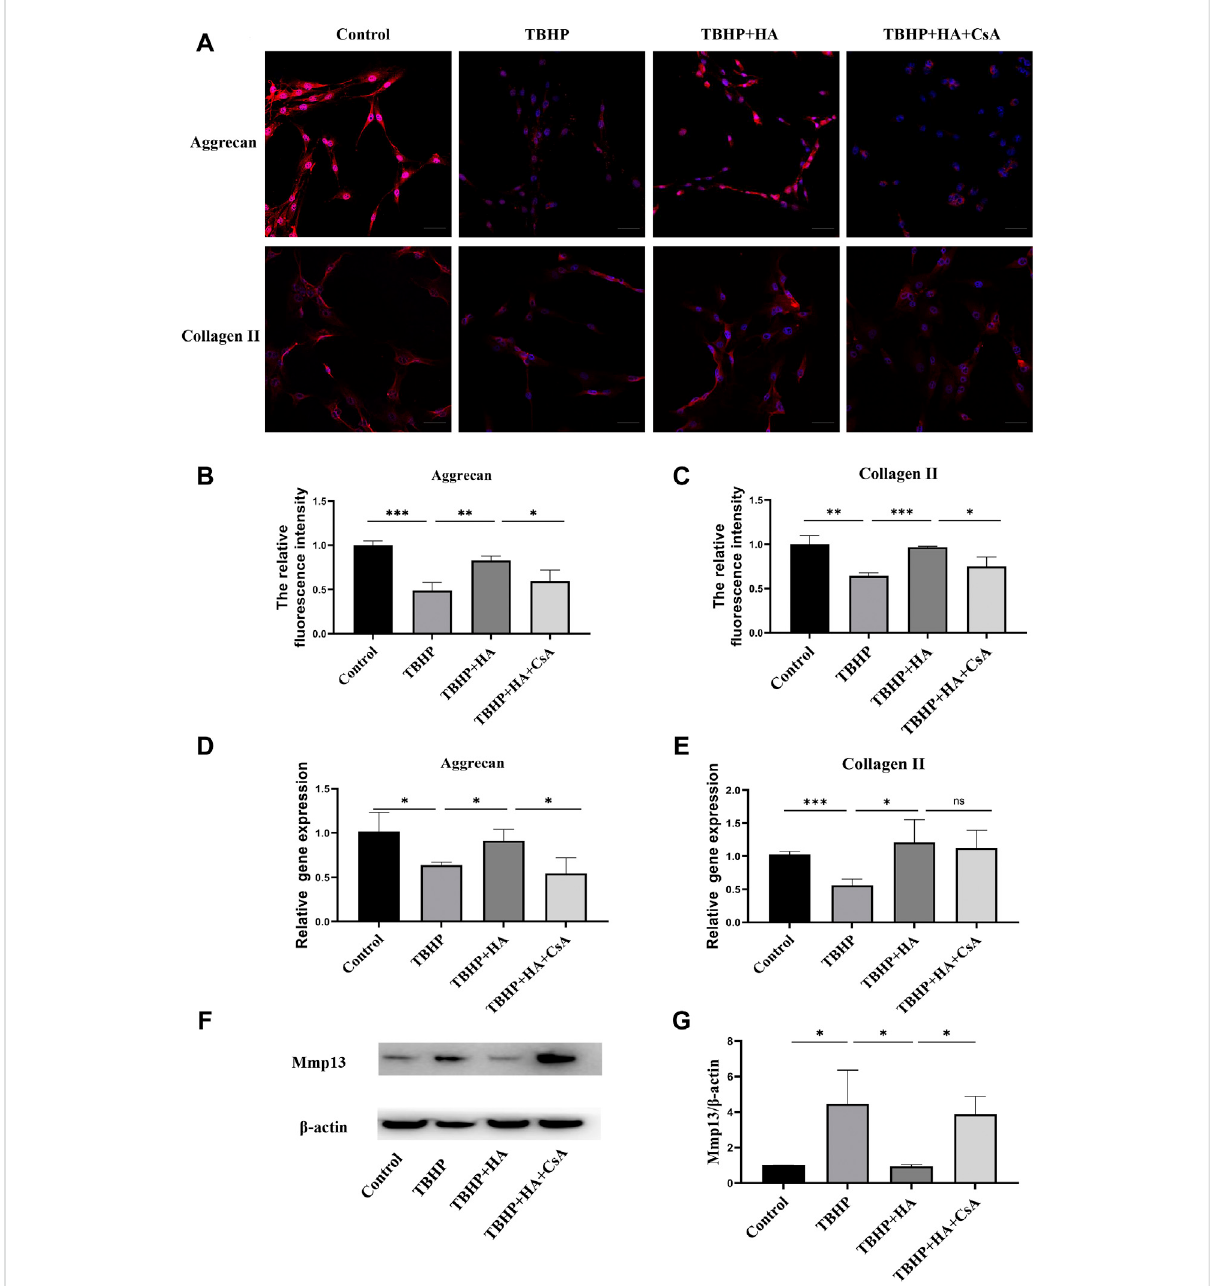
FIGURE 4 HA attenuates TBHP-induced ECM degradation in NPCs. (A – C) The protein expression of Aggrecan and Collagen II was detected by the immuno fl uorescence staining. (D,E) The gene expression of Aggrecan and Collagen II was analyzed by RT-qPCR. (F,G) The protein expression